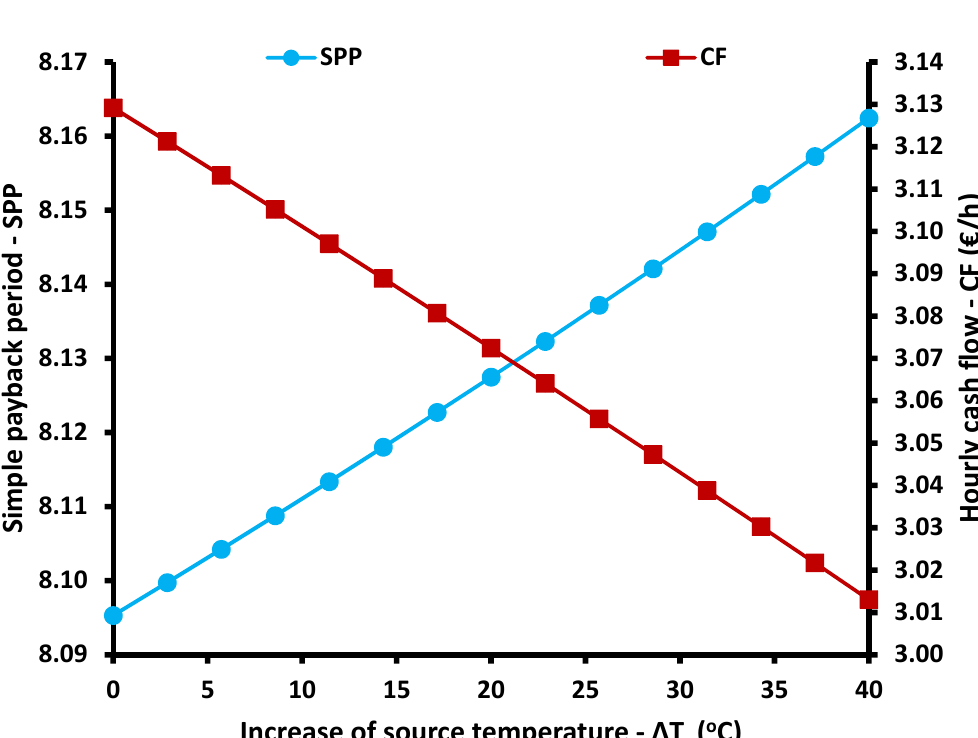
Figure 10. Simple payback period and hourly cash flow for different heating source temperature difference values.